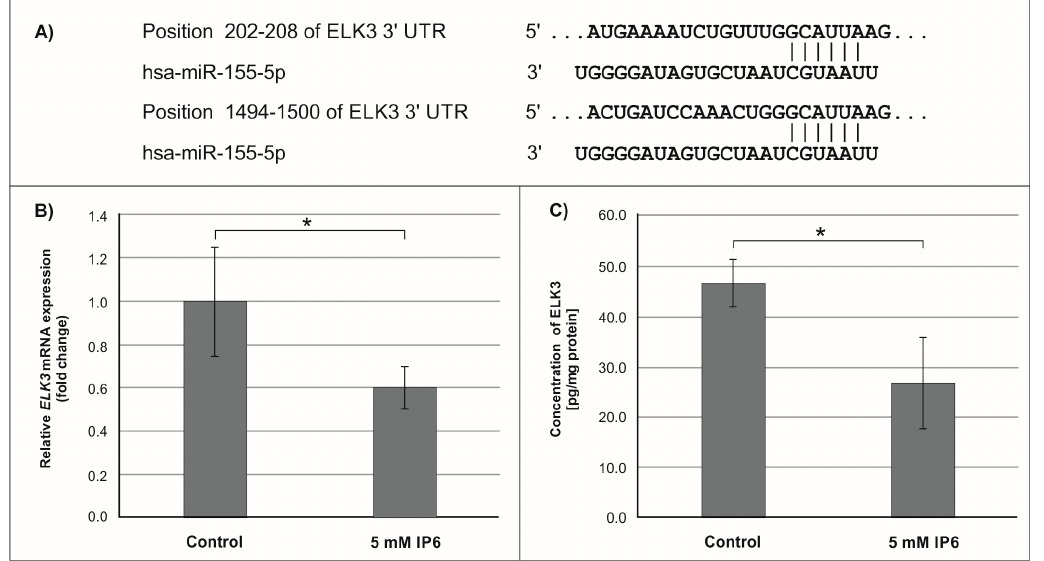
Figure 6. Effect of 5 mM IP6 on ELK3 gene expression in Caco-2 cells at 24 h. ( A ) Schematic of the putative binding sites of miR-155-5p in 3 ′ -UTR of ELK3 mRNA, as determined by bioinformatics analysis. ( B ) Changes in ELK3 mRNA expression in Caco-2 cells, as determined by RT-qPCR. ( C ) Changes in ELK3 protein concentration in Caco-2 cells, as determined by ELISA test. The results are presented as mean ± SD of three separate experiments; * p < 0.05 versus control.